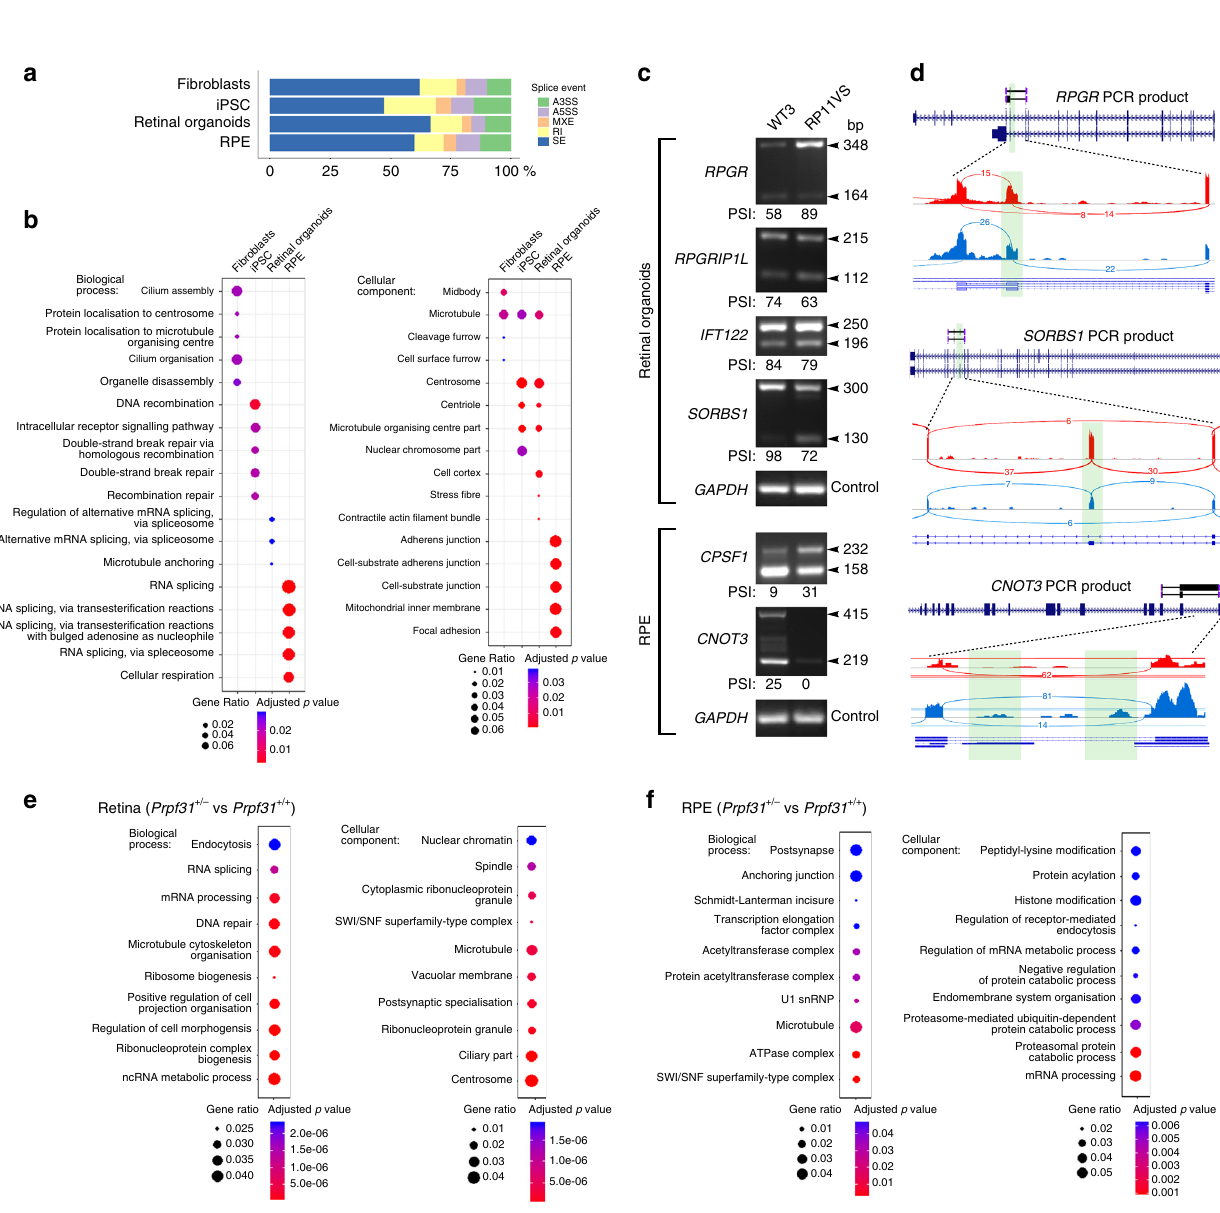
Fig. 4 RNA-seq analysis of alternative splicing in fi broblasts, iPSC, RPE, retinal organoids and Prpf31 + / − retina. a rMATS analysis showing that RP11 - RPE have the highest percentage of transcripts containing retained introns (RI) and alternative 3 ′ splice sites (A3SS); b Gene Ontology enrichment analysis showing biological and cellular processes affected by alternative splicing, respectively, in human cells; c Gel electrophoresis of RT-PCR for the indicated genes in RPE and retinal organoids derived from patient RP11VS and unaffected control WT3. Sizes (in bp) for major and minor isoforms (arrowheads), and percentage-spliced-in (PSI) values, are indicated; d Sashimi plots for the indicated genes for validation of alternative splicing events in RPE and retinal organoids derived from RP11 patients (blue) and unaffected controls (red). Data are representative of at least three independent experiments. Green highlights in Sashimi plots indicate alternative splicing events with the number of junction reads indicated for each event; e , f Gene Ontology enrichment analysis showing biological and cellular processes affected by alternative splicing, respectively, in mouse Prpf31 + / − retinae and RPE. Data are representative of at least three independent experiments NATURE COMMUNICATIONS| (2018) 9:4234 |DOI: